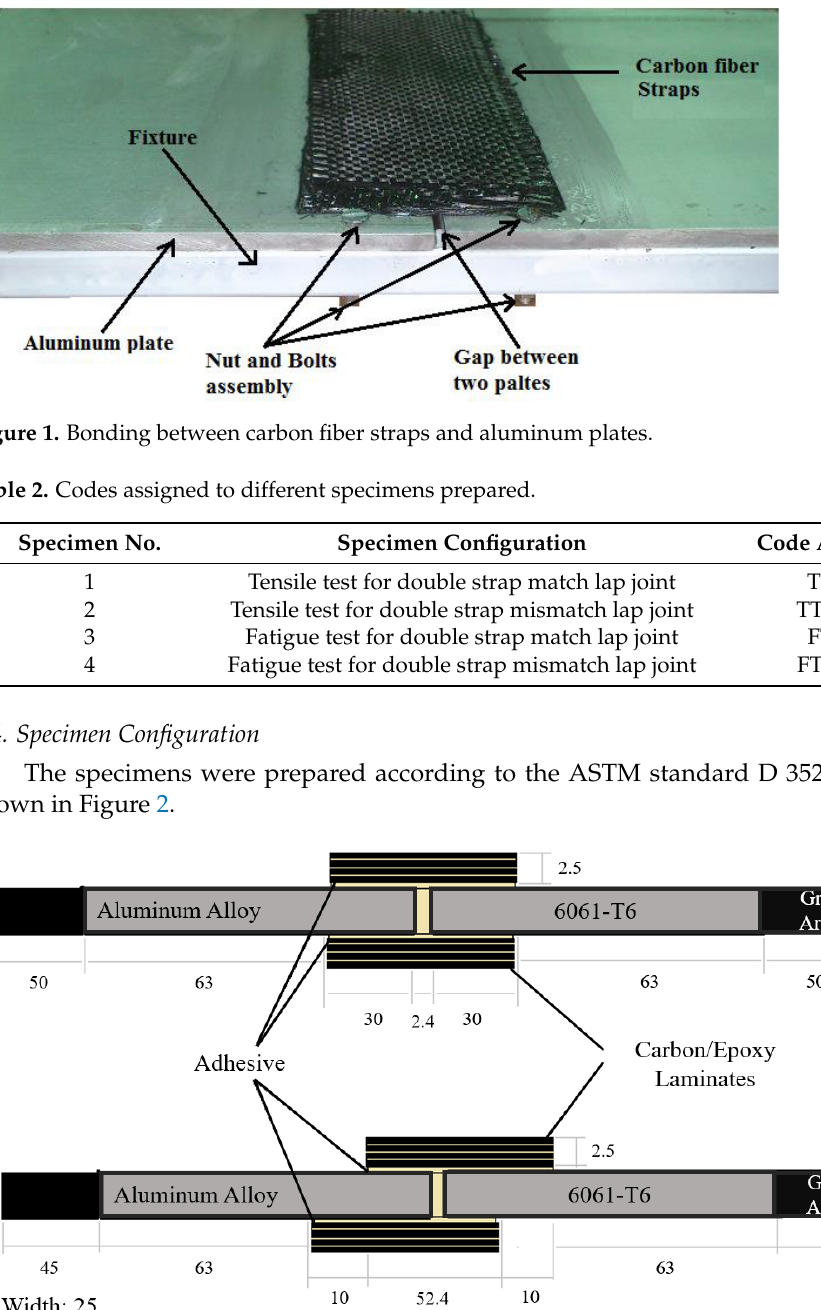
Figure 1. Bonding between carbon fiber straps and aluminum plates.